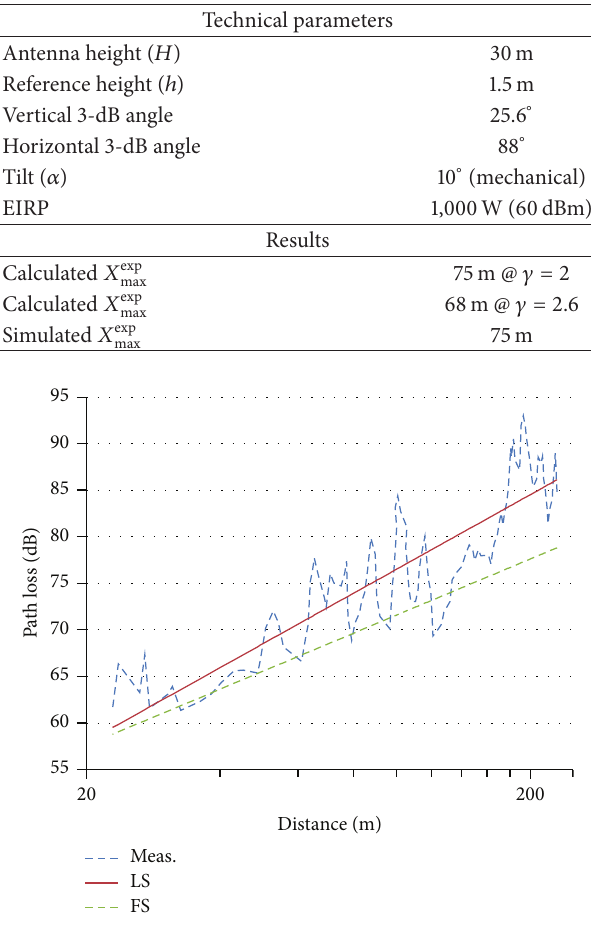
Figure 6: Path loss westward of the transmitter located at 300 Slater Street. In this case, the PL = 23.4 + 26.6 log (𝑑) , with 𝜎 = 3.84 , was obtained using least square (LS) regression analysis and then compared with free space (FS). The intercept point between both models is 18m.